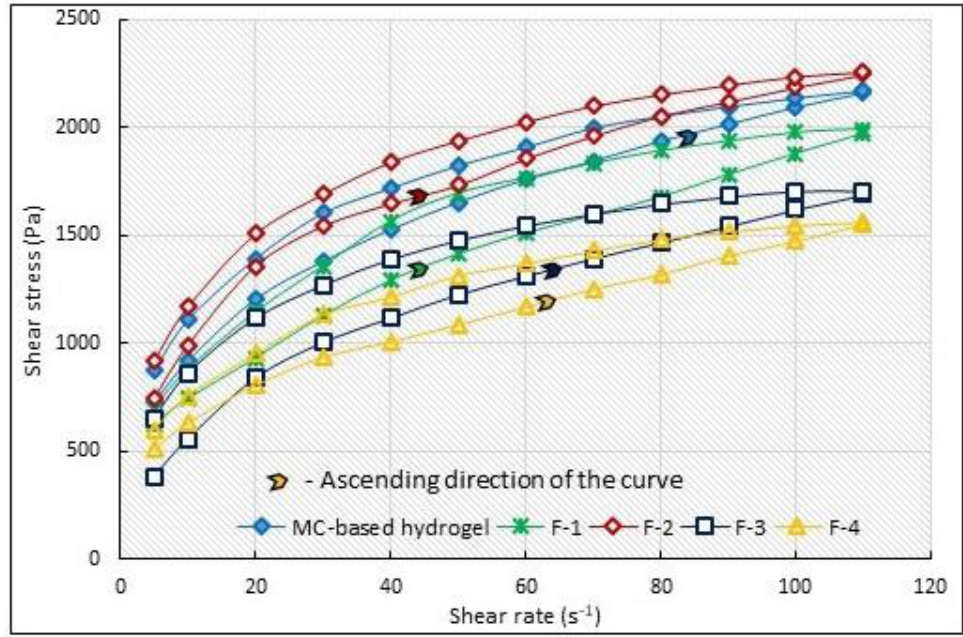
Figure 4. Hysteresis loops for formulations containing STH at concentration 0.1% — F-1 and STH with addition of ALB: F-2 at concentration STH:ALB 0.1%:0.1%, F-3 at concentration STH:ALB 0.1%:0.2%), F-4 at concentration STH:ALB 0.1%:0.5% and unloaded hydrogel base, containing MC ( n = 6).